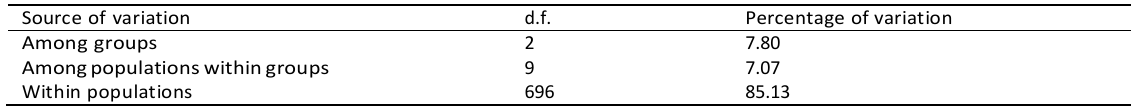
Table 6. Percent of the variation explained by grouping populations according to their geographical region on the analysis of molecular variance (performed with